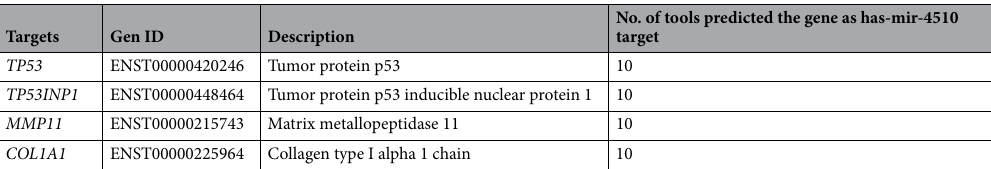
Table 5. Target predicted genes had complementary bases with the miR-4510 seed site.